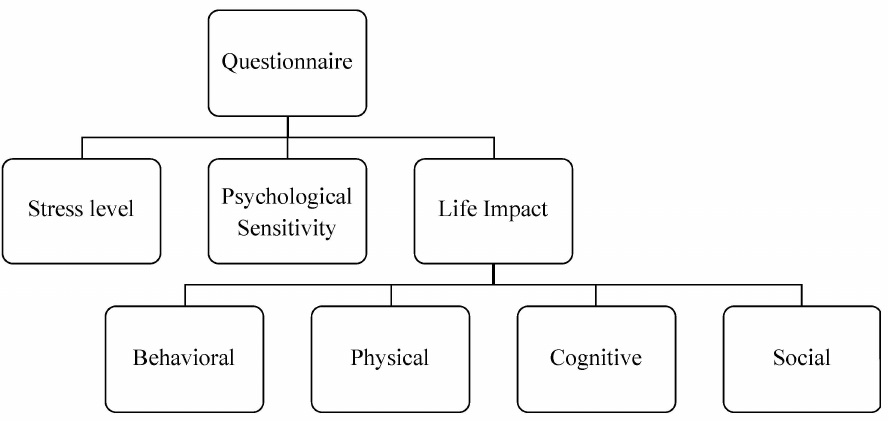
Figure 1. Structure of the questionnaire